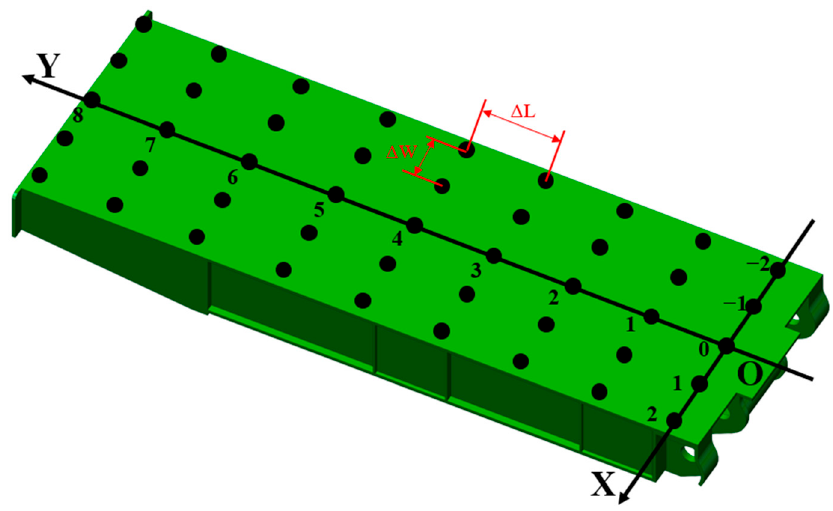
Figure 4. Location of the impact load.